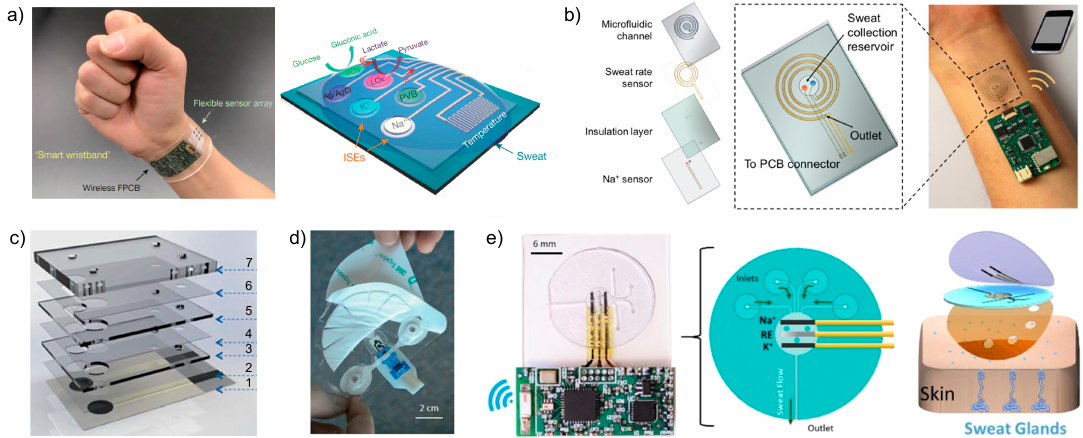
Figure 2. ( a ) Images of the wearable sensor reported by Gao et al. that is placed on a subject’s wrist, integrating the sensor array and wireless transmission. The array consisted of glucose-, lactate-, sodium- and potassium-selective electrodes together with the reference electrode (PVB reference membrane) and the temperature sensor. GOx and LOx are glucose and lactate oxidase, respectively. Reproduced from [26] with permission from Springer Nature. ( b ) Scheme of the four layers that constitute the wearable sensing patch reported by Nyein et al. The spiral Au electrode for sweat rate sensing is aligned with the microfluidic channel. The sodium and reference electrodes are placed in the sweat collection reservoir. The path can be worn on the user’s wrist and the data is wireless transmitted to a phone via Bluetooth. Reprinted from [39], with permission from the American Chemical Society, Copyright 2018. ( c ) Image of the different layers employed to produce the wearable sensor reported by Matzeu et al. Reproduced from [41] with permission from The Royal Society of Chemistry. ( d ) Image of the sweat patch developed by Alizadeh et al. The dimensions are 10.5 cm × 9.7 cm. Reproduced from [42] with permission from The Royal Society of Chemistry. ( e ) On the left: Photograph and schematic of the microfluidic device integrated with the Na + and K + electrodes described by Sempionatto et al. On the right: Skin-mounted device, which comprises a three-layered configuration. Reproduced from [27] with permission from John Wiley & Sons, Inc.